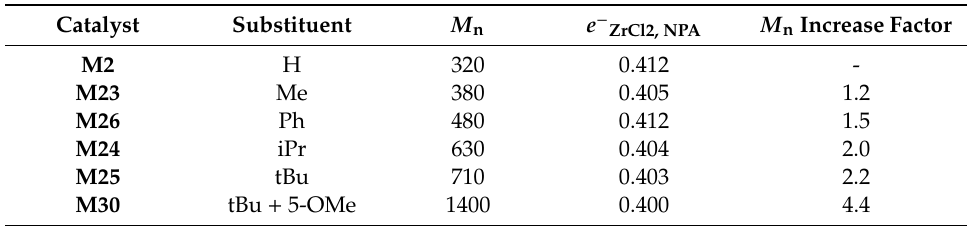
Table 4. E ff ect of the 6-position substituents on the charge on the ZrCl 2 fragment (see text) and PP M n (in kDa). For all catalysts 4-R = Ph.